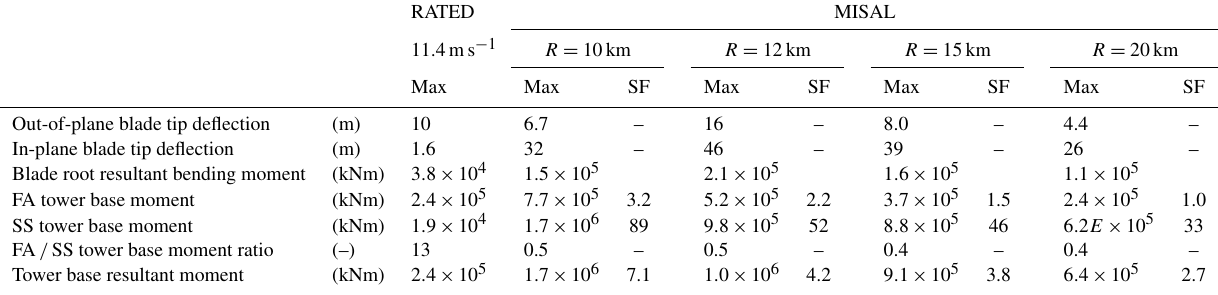
Table 7. Maxima of blade and tower structural response to the MISAL case. The scale factor (SF) indicates the magnitude of response relative to RATED. Cells highlighted in gray indicate values that exceed the Eurocode strength basis value for the tower (5 . 4 × 10 5 kNm) or the 18m deflection limit on the blade tip. Numerical values of the scale factors are not provided when not appropriate (for blade deflections the blade is oriented differently in the rated case, and the scaling of FA / SS tower base moment ratios is not a meaningful measure of response).